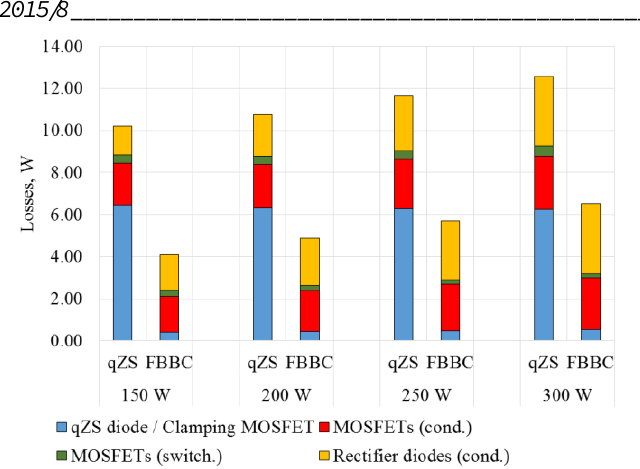
Fig. 6. Semiconductor power losses breakdown of the qZS and IFBB converters.